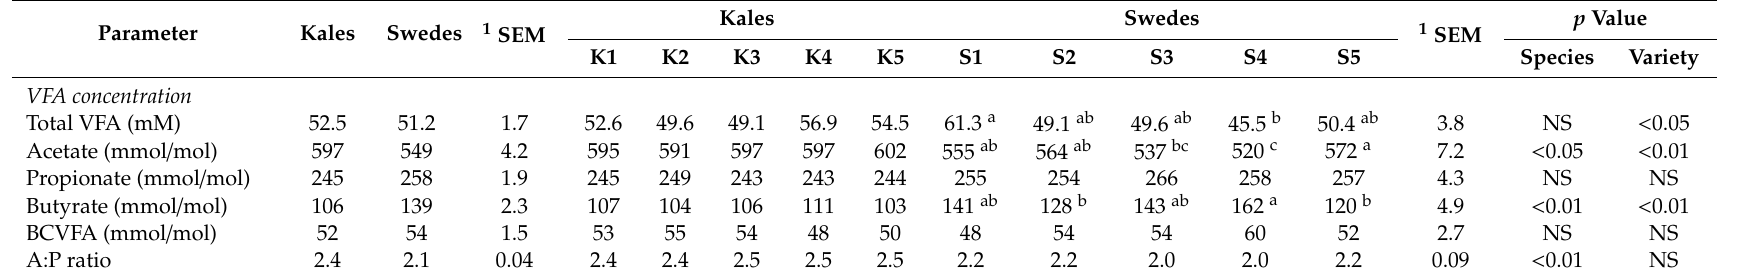
a,b,c within a row, di ff erent letters represent the significant di ff erences at p value < 0.05. 1 SEM standard error of the mean; BCVFA, branched-chain VFA (isobutyrate + isovalerate + valerate); A:P ratio, acetate to propionate ratio. Kale varieties: K1, Caledonian; K2, Elba; K3, Sovereign; K4, Regal; K5, Coleor. Swede varieties: S1, Major Plus; S2, Aparima; S3, Highlander; S4, Dominion; S5,